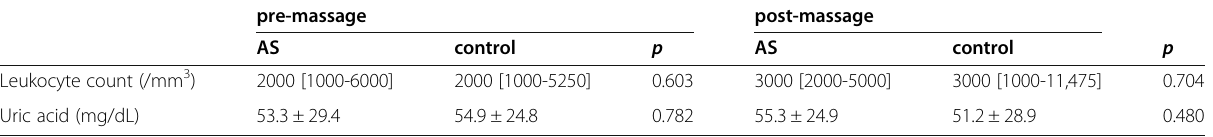
Table 2 Comparison of pre- and post-massage urinary tests between AS patients and healthy controls (excluding participants with positive urinary